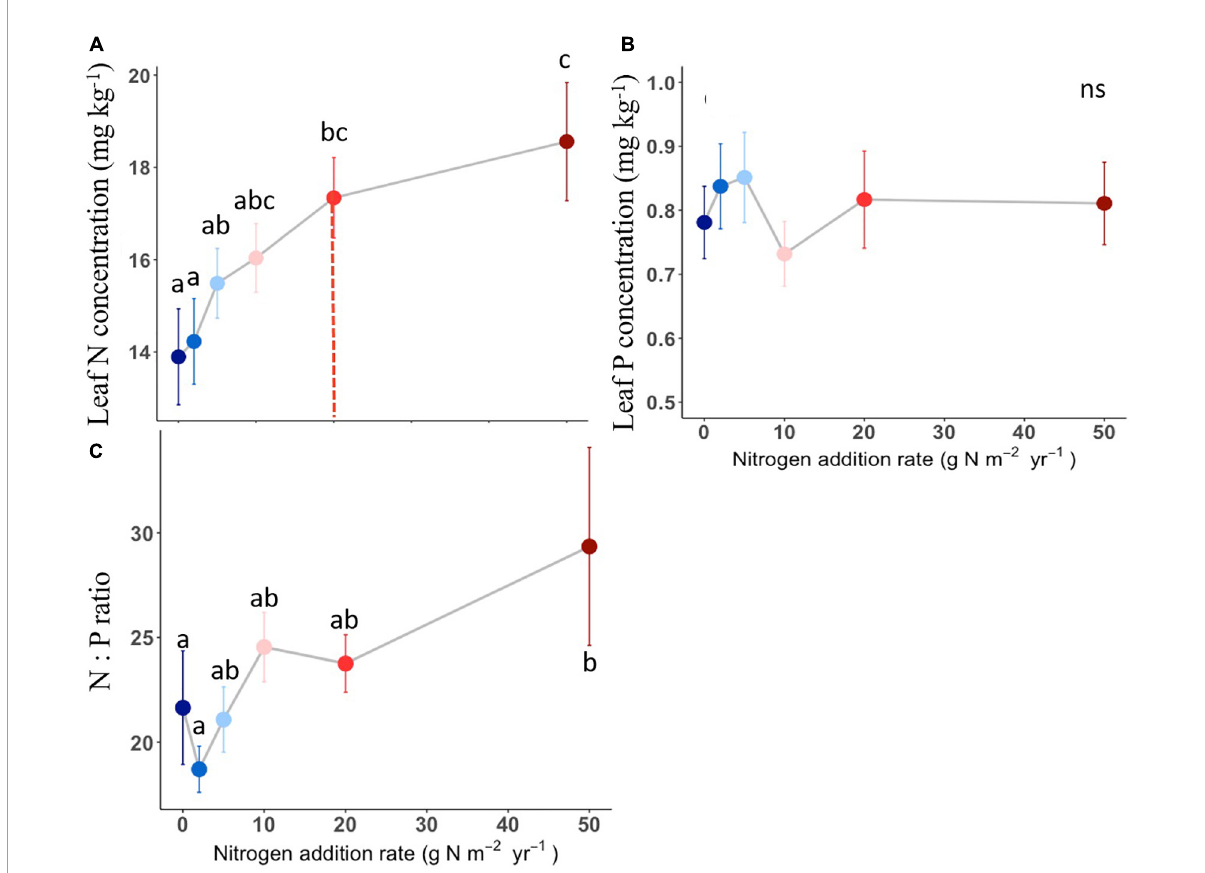
FIGURE2 Effects of N addition on leaf stoichiometry of L. chinensis . Trait abbreviations are leaf N concentration (A) , leaf P concentration (B) , leaf N: P mass ratio (C) . Different lower-case letters indicate significant differences ( P < 0.05) between treatments, and ns indicates non-significant ( P > 0.05). The dashed line in each panel indicate for tipping points. The data shown are the means with 40 replications ± standard